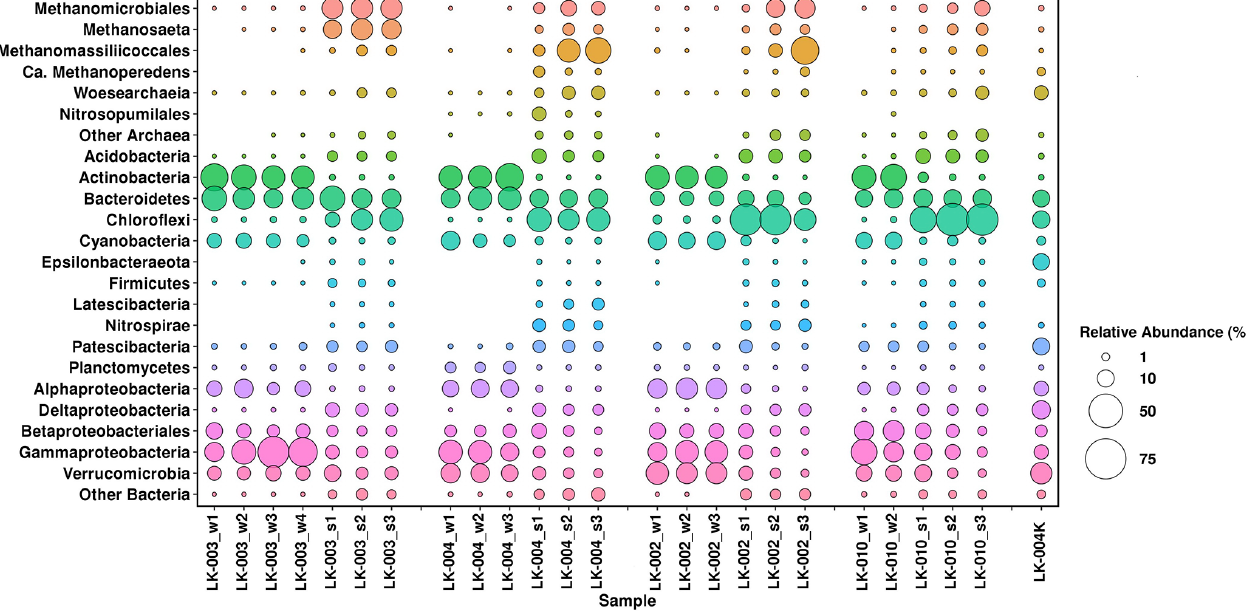
Figure 7. Microbial communities of the water column and bottom sediments in four tundra Lakes of Yamal Peninsula determined by high- throughput sequencing of 16S rRNA genes. On the x axis, “ w ” and “ s ” after the sample designation indicate the water and sediment samples,